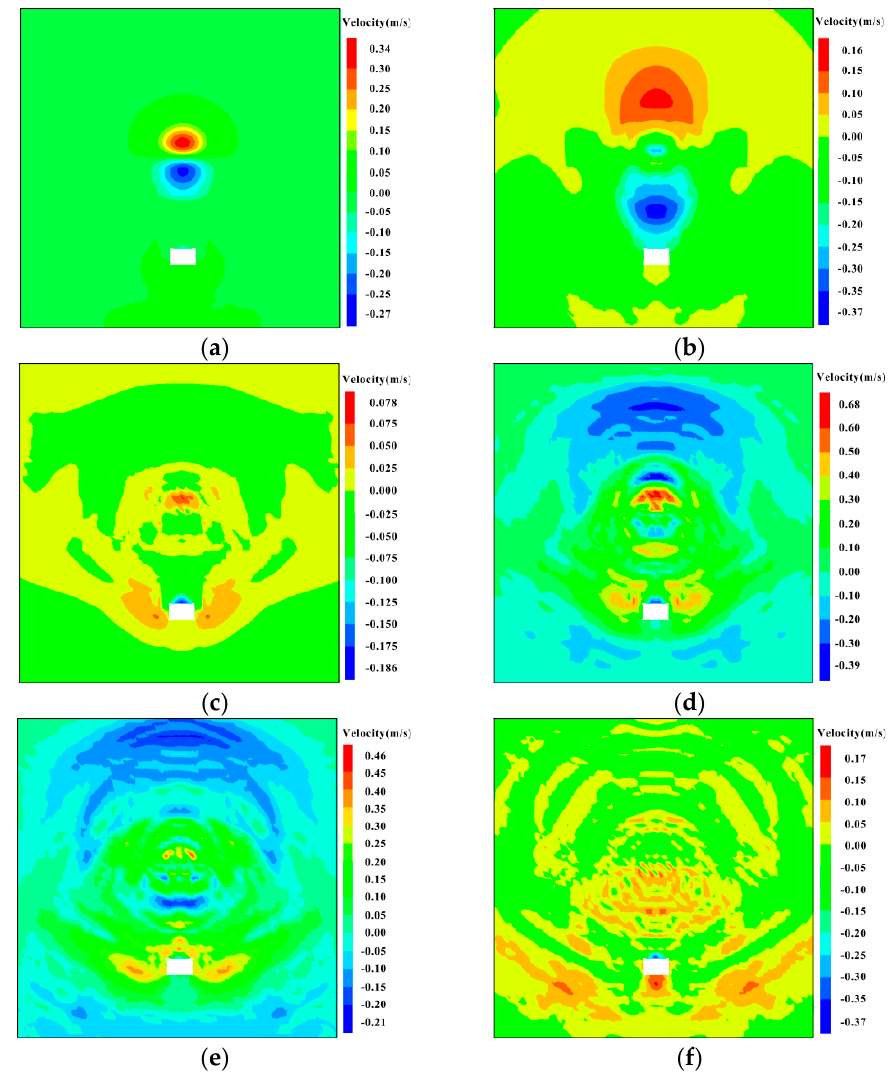
Figure 6. Propagation process of the stress wave in the surrounding rock of the roadway (60 MPa). ( a ) 0 s; ( b ) 0.01 s; ( c ) 0.02 s; ( d ) 0.04 s; ( e ) 0.06 s; ( f ) 0.07 s.